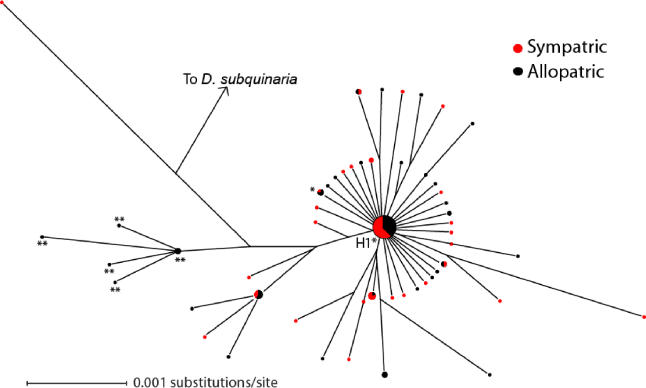
Minimum-Spanning Tree for D. recens COI
Red dots are samples collected from the sympatric populations, and black dots are samples collected from the allopatric populations. Haplotypes marked with an asterisk were found in the Smokies as well as other areas, and those marked with double asterisks were found only in the Smokies. The areas of the circles are proportional to number of samples with each haplotype. H1 is the most abundant haplotype (n = 66). Distance to outgroups can be seen in Figure 6.